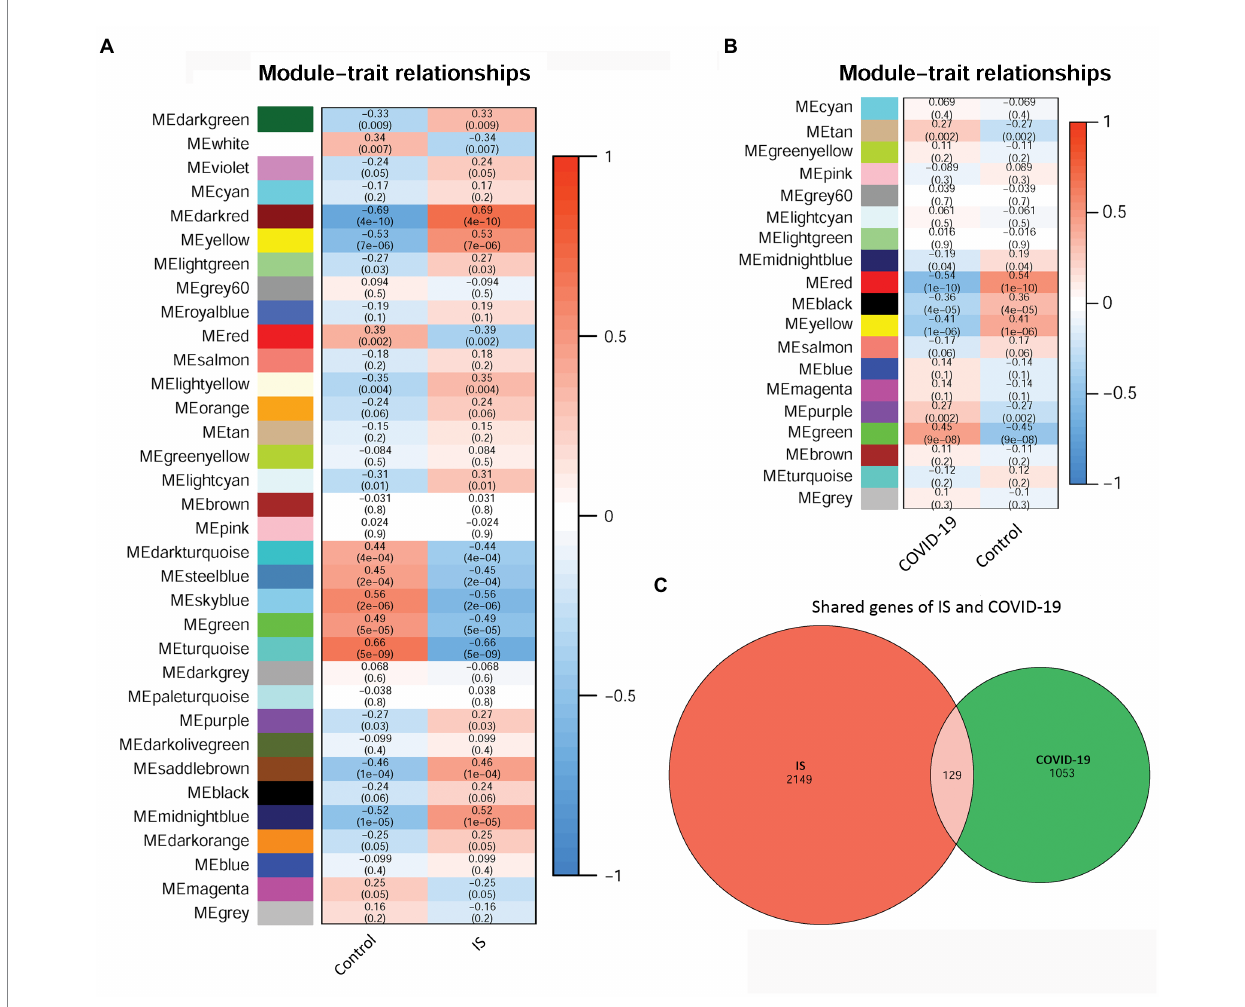
FIGURE 3 The relationships between WCGNA modules and clinical features of IS and COVID-19. (A) Heat map of module–trait relationships in IS. (B) Heat map of module–trait relationships in COVID-19. (C) Venn diagram showed the shared genes of IS and COVID-19. WCGNA, Weighted correlation network analysis; IS, ischemic stroke; COVID-19, coronavirus disease